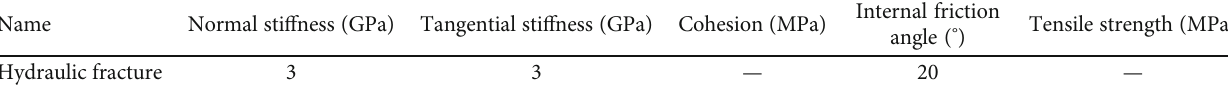
Table 3: Physical and mechanical parameters of interface element.